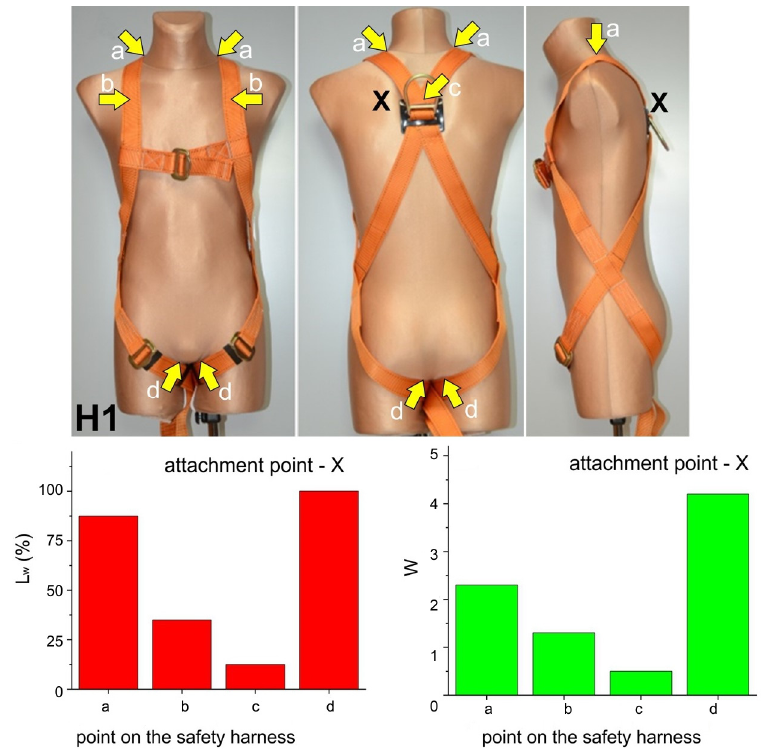
Figure 3. Test results for harness H1.